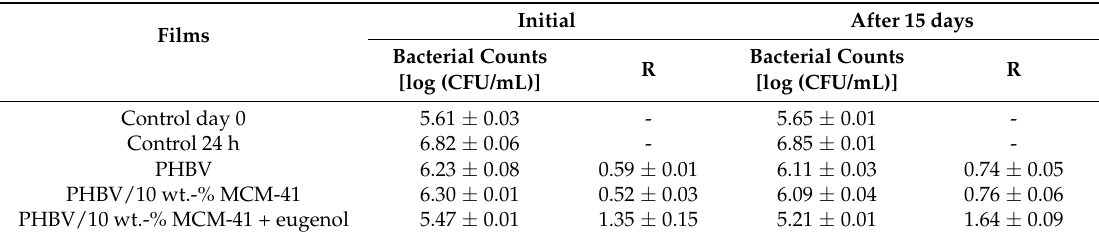
Table 8. Antibacterial activity against Staphylococcus aureus ( S. aureus ) in the closed system for the electrospun films of poly(3-hydroxybutyrate- co -3-hydroxyvalerate) (PHBV) and PHBV/Mobil Composition of Matter (MCM)-41 with eugenol.